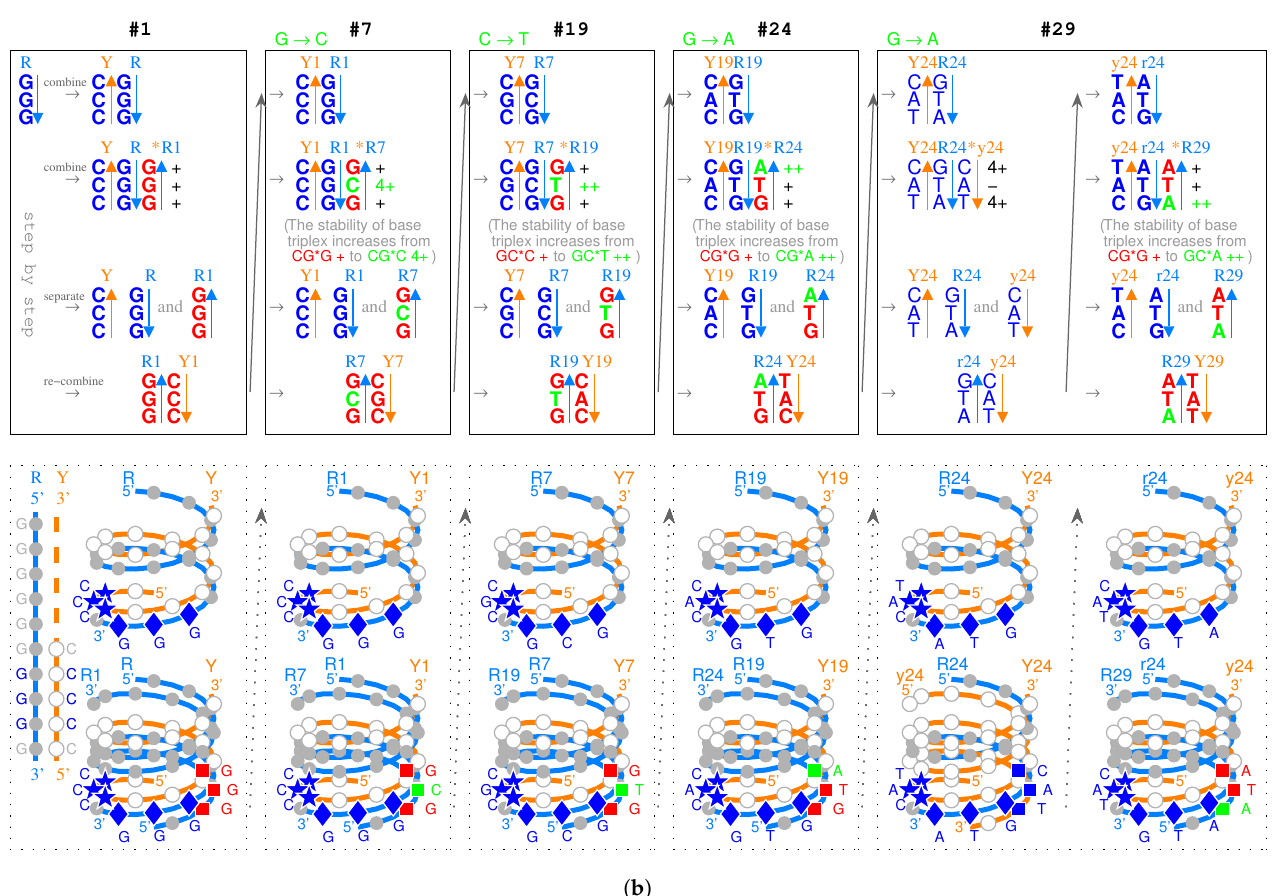
Figure 1. The origin of the genetic code. ( a ) The roadmap for the evolution of the genetic code. The 64 codons formed from base substitutions in triplex DNAs are in red. Only three-base-length segments of the triplex DNAs are shown explicitly; the whole length right-handed triplex DNAs are indicated in Figure 1b. In each position # n ( n = 1,2, . . . ,32), the # n codon pair on Rn , and Yn is in red. The relative stabilities of the triplex base pairs ( − , +, ++, 4+) are written to the right of the base triplexes, where the increased relative stabilities of triplex base pairs in base substitutions are indicated in green. Each triplex DNA is denoted by three arrows, whose directions are from 5’ to 3’. The YR ∗ R triplex DNAs are in pink, and the YR ∗ Y triplex DNAs in azure. The recruitment order of codon pairs are from #1 to #32, and the recruitment order of the 20 amino acids are to the left of them, respectively. Non-standard genetic codes are indicated by brackets beside the corresponding amino acids. The Route 0 − 3 and Hierarchy 1 ∼ 4 are indicated to the right of and below the roadmap, respectively. The evolution of the genetic code are denoted by black arrows, beside which pair connections are indicated by the corresponding amino acids. Refer to an example in Figure 1b to understand details of the roadmap; refer to Figure 2 to understand the critical role of relative stabilities of triplex base pairs in achieving the real genetic code; refer to Figure 5a,b to see the origin of tRNAs; refer to Figure 3a to see the coherent relationship between the recruitment orders of codons and amino acids; refer to Figure 3b to see the codon degeneracy in the symmetric roadmap. ( b ) A detailed description of the roadmap (see Supplementary Movie S1). Taking, for example, from #1 to #29, the evolution of the genetic code from #1, to #7, to #19, to #24, and, at last, to #29 are explained in detail in the upper boxes, and the corresponding right-handed single-stranded, double-stranded, and triple-stranded DNAs are shown in the lower boxes,